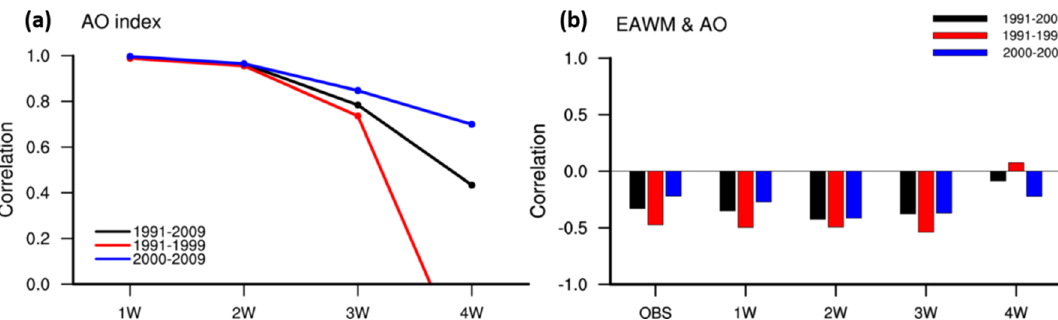
Figure 10. ( a ) Correlation coefficient of the Arctic oscillation (AO) between ERA–Interim and GloSea5 with lead times of 1–4 weeks. ( b ) Relationship of AO and the East Asia winter monsoon (EAWM) index from ERA–Interim and GloSea5 with lead times of 1–4 weeks. Red bars are averaged for 1991 – 1999 and blue bars are averaged for 2000 – 2009.